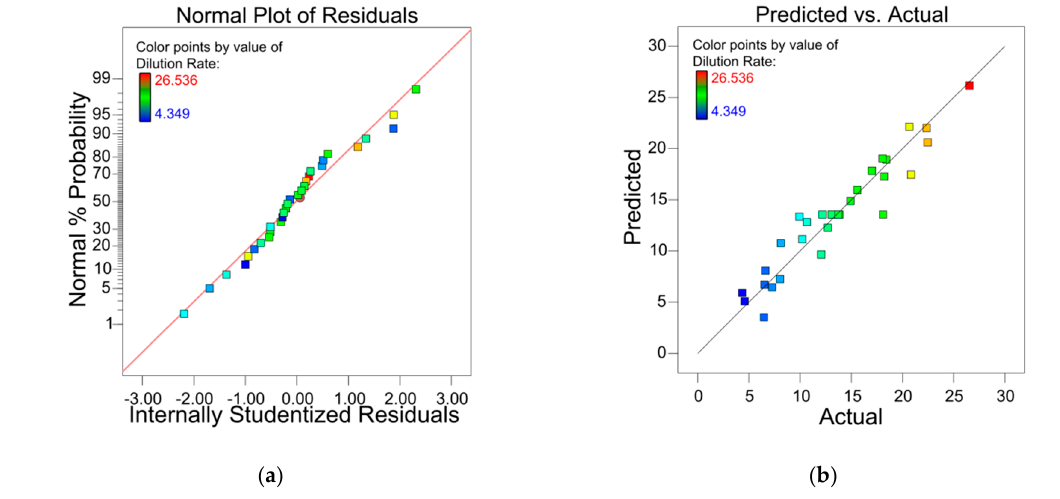
Figure 13. ( a ) Dilution rate model plot of residuals. ( b ) Dilution rate model prediction and actual comparison.